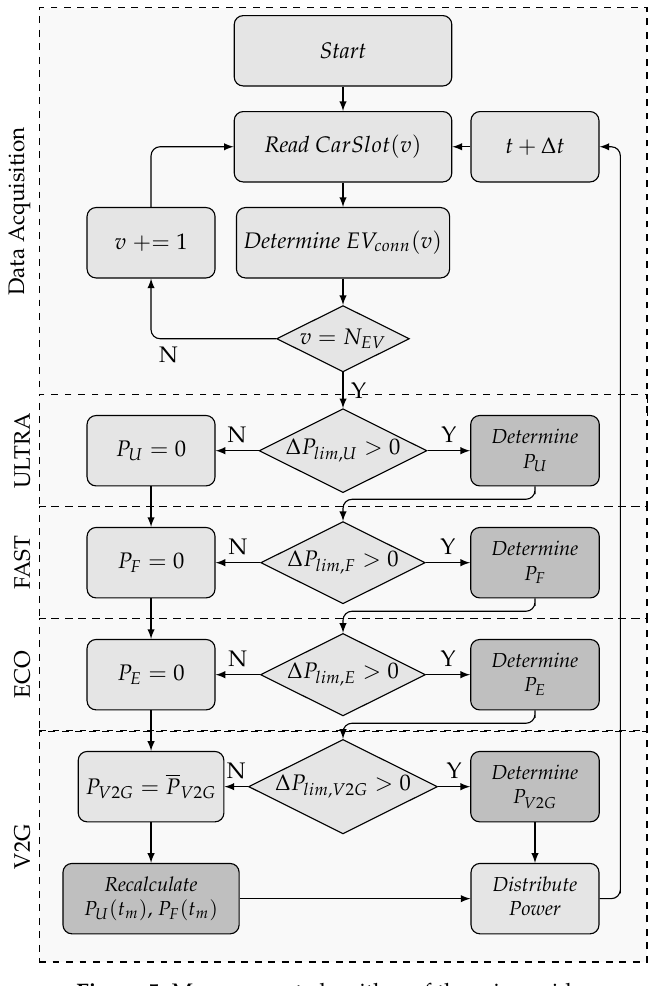
Figure 5. Management algorithm of the